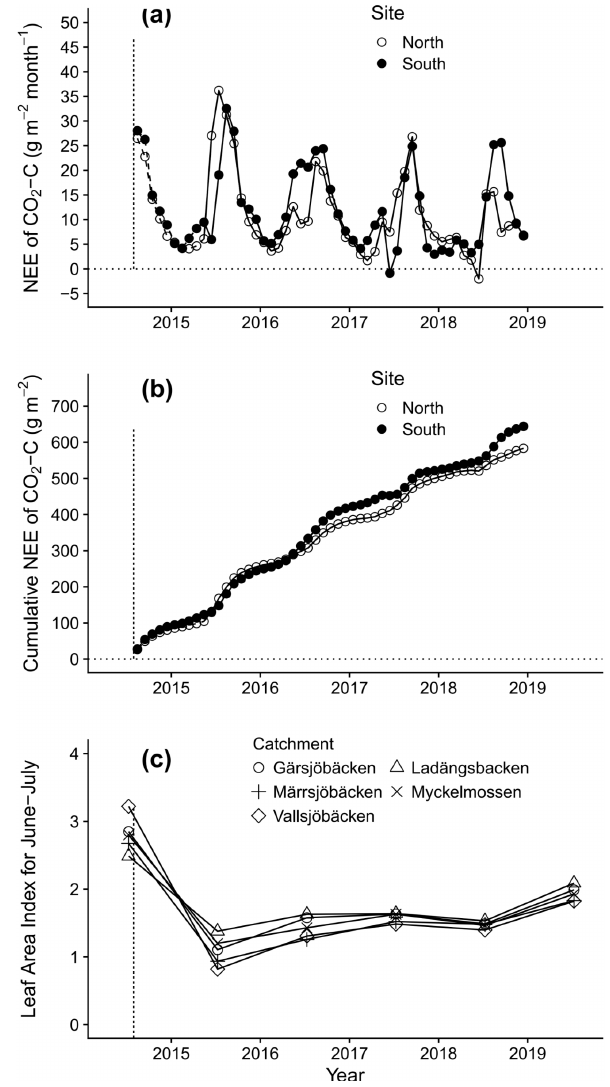
Figure 2. Carbon fluxes from two burned areas measured by eddy covariance and changes in leaf area index (LAI) for the five catch- ments. (a) Monthly CO 2 -C fluxes and (b) cumulative CO 2 -C flux. The dashed line indicates the period of modelled fluxes. Positive values mean emissions to the atmosphere. (c) Changes in mean summer (June 15–July 28) LAI over time of the burned parts of the catchments. First year (2014) shows LAI prior to the fire. Data are from MODIS (500m grid). The fire occurred in August 2014 and is indicated by a dashed vertical